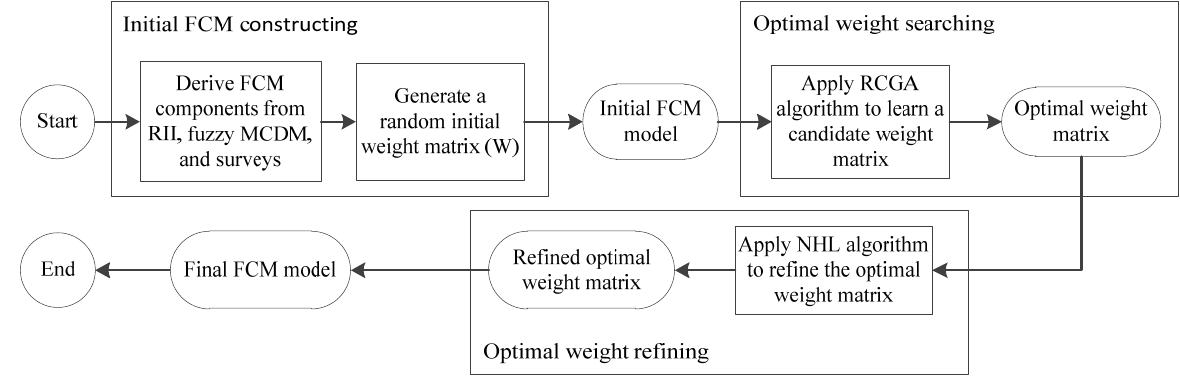
Figure 5. Flow chart for construction of FCM model for quantifying improvement strategies’ impact on CLP. Initial FCM construction included causal relationships among the initial FCM param- eters (i.e., the most value-adding factors and CLP) and initial states of the parameters ac- cording to the dataset, surveys results, and past studies.